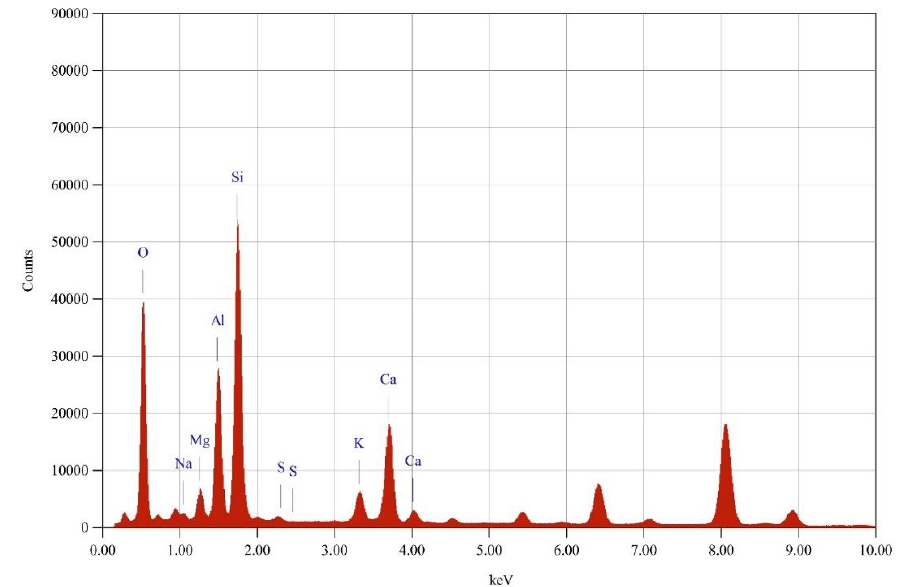
Figure 2. Energy-dispersive X-ray spectroscopy (EDS) spectrum obtained by TEM. The graph highlights the main chemical elements.